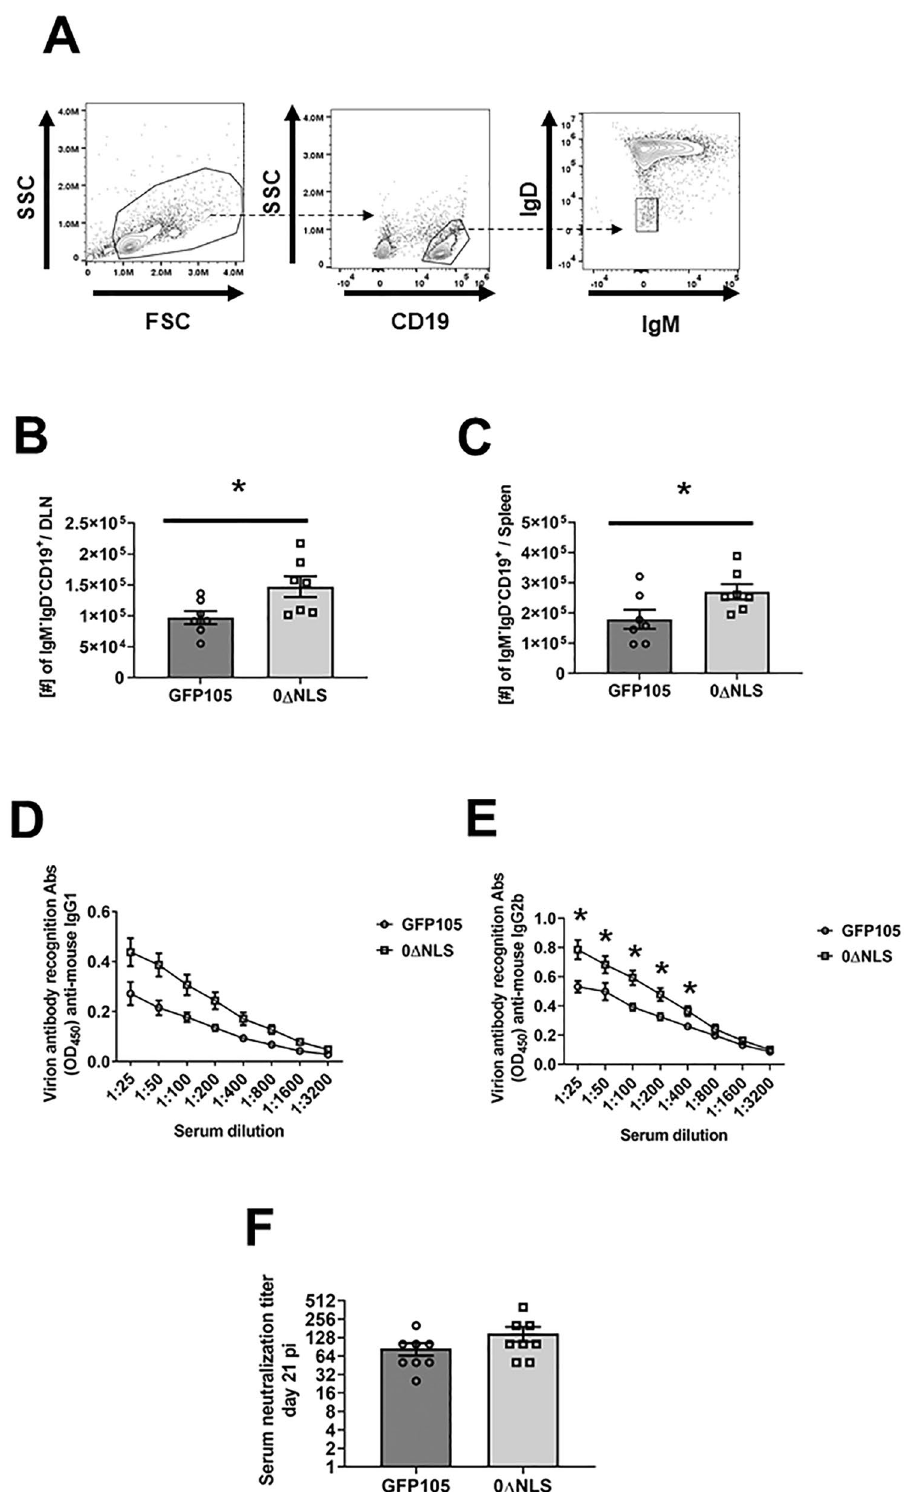
Figure 2. 0∆NLS vaccination induces higher numbers of class-switch B cells along with an increase in HSV-1 IgG2b titers. C57BL/6 mice (n = 7–8/group) were injected in the footpad with the HSV-1 parental (GFP105) or live-attenuated HSV-1 0ΔNLS at 10 5 plaque forming units in 10 µl PBS. Mice were euthanized at day 7 and day 21 post-vaccination and the number of class-switched B cells was determined at day 7 in the PLN and day 21 in the spleen post-immunization. At day 21 post-vaccination, sera were obtained and stored at –80 °C until it was assayed for anti-HSV-1 antigen reactivity and virus neutralization. Panel A presents a gating strategy for class-switched B cells (CD19 + IgM - IgD - ). Panels B and C present class-switched B cell numbers in the PLN and spleen of vaccinated animals, respectively. Panels D and E show anti-HSV-1 IgG1 and IgG2b immunoglobulin titers. Panel F presents antibody neutralization titers from sera of HSV-1 GFP105- and 0ΔNLS-vaccinated mice collected at day 21 post-immunization. The results are presented as the mean ± SEM, * p < .05 as determined by Student’s t